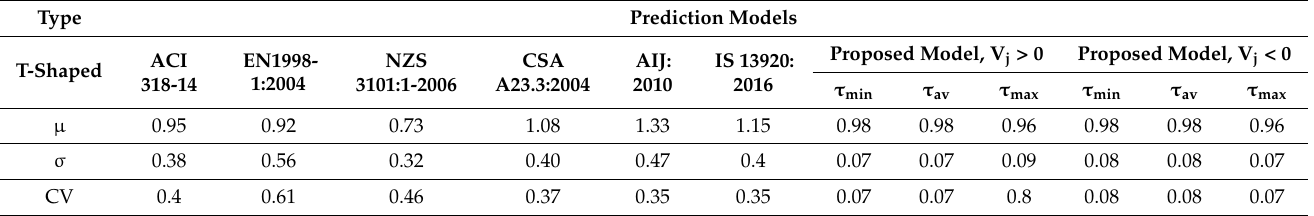
Table 2. Average value, µ , standard deviation, σ , and coefficient of variation (CV) of the ratios of experimental ultimate column shear and available prediction models for T-shaped RC joints.